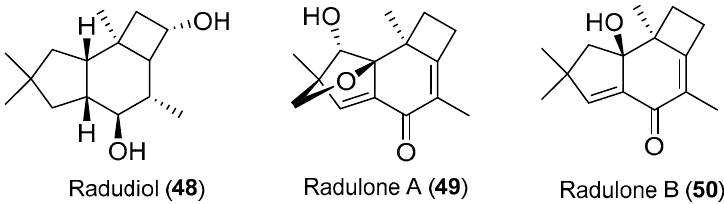
Figure 10. Structures of protoilludanes 48 – 50 isolated from Radulomyces confluens.